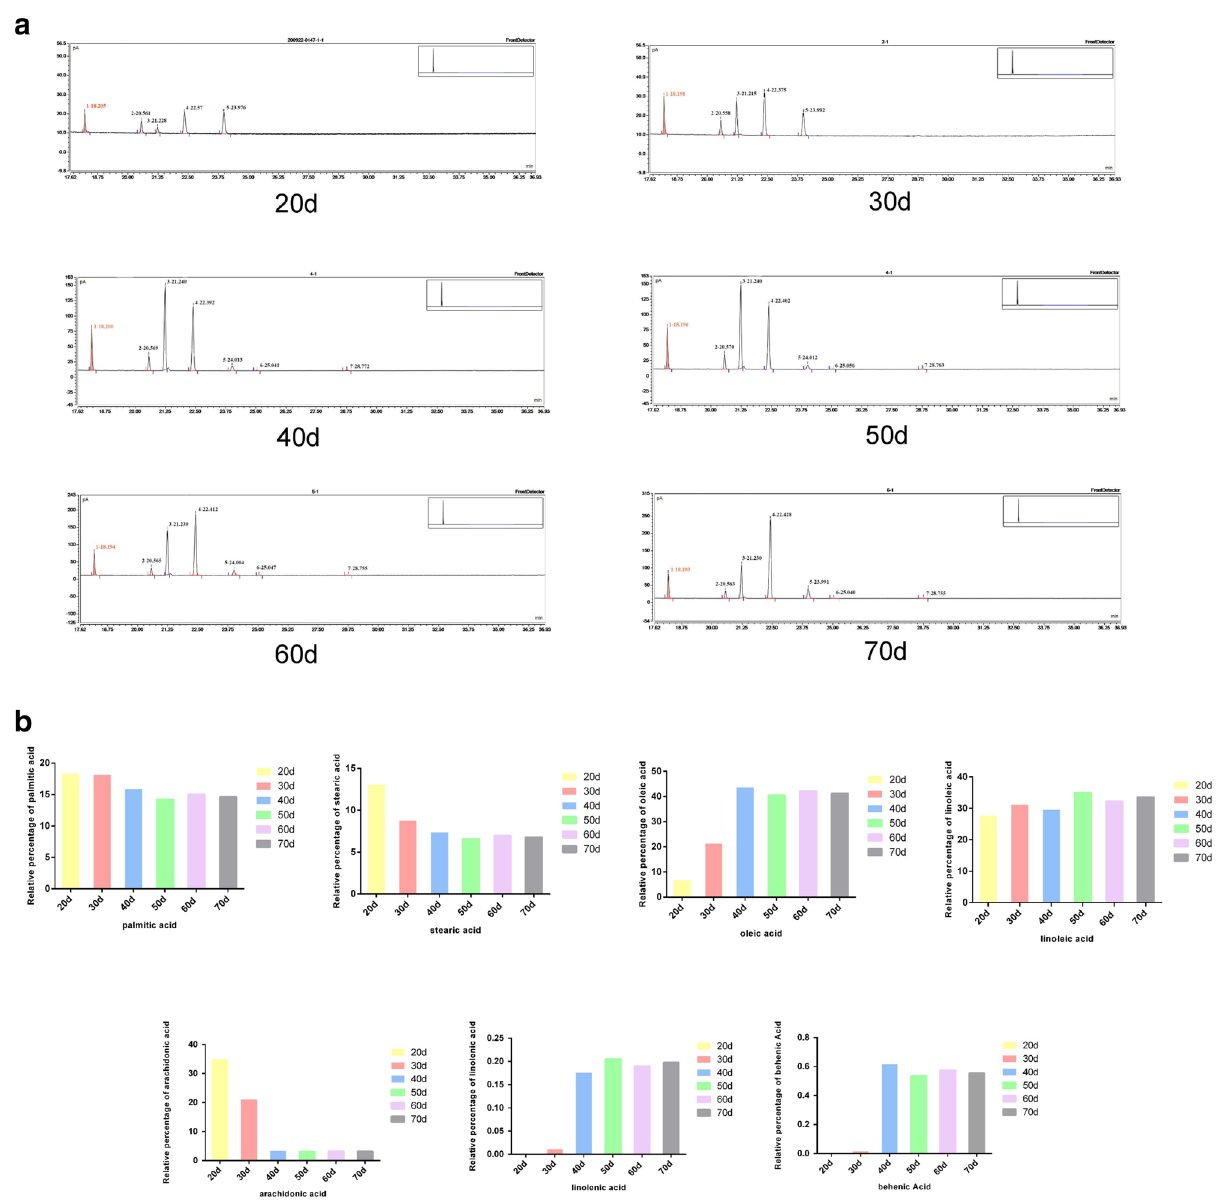
Figure 3. The gas chromatogram of soybean pods at different stages. ( a ) Gas chromatographic peak of fatty acid content in soybean at different stages (The starting points from left to right are palmitic acid, stearic acid, oleic acid, linoleic acid, arachidonic acid, linolenic acid and behenic acid). ( b ) The relative content of fatty acids in soybean in different